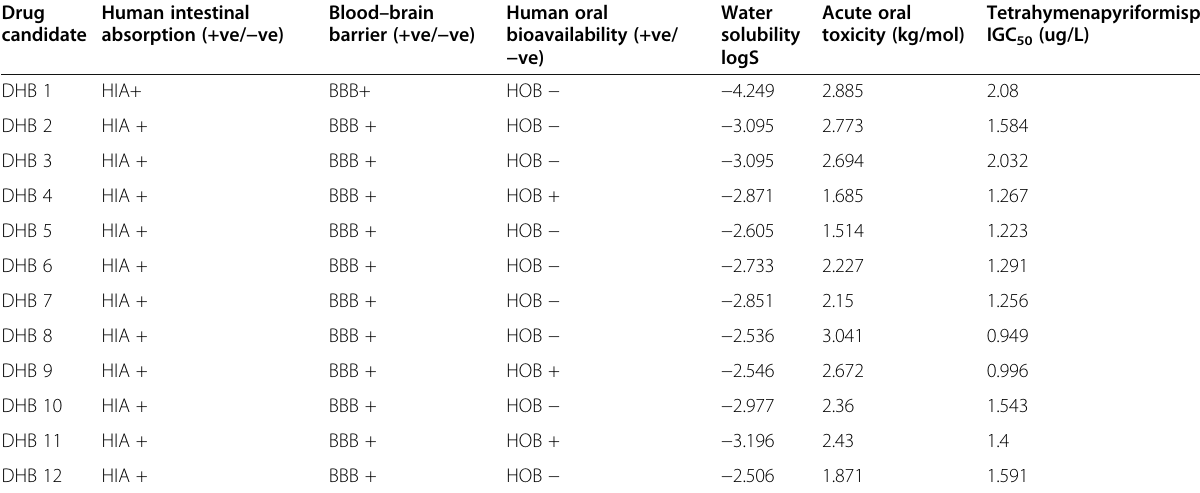
Table 2 Data for ADMET parameters Drug Human intestinal candidate absorption (+ve/ −